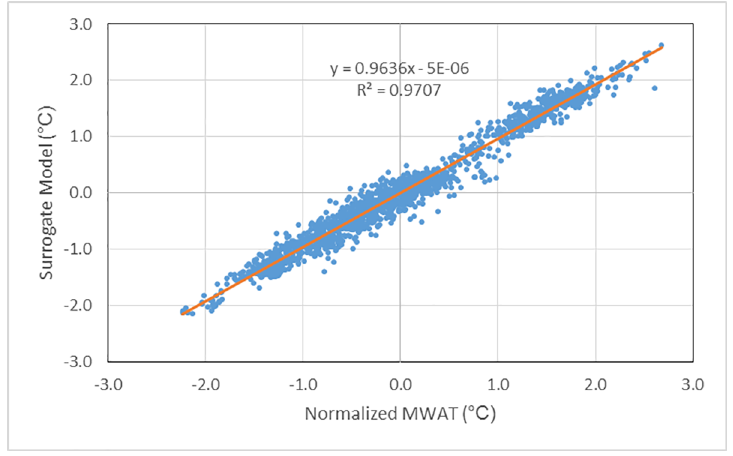
Fig 2. Surrogate model fit to LISSS model runs for MWAT above the